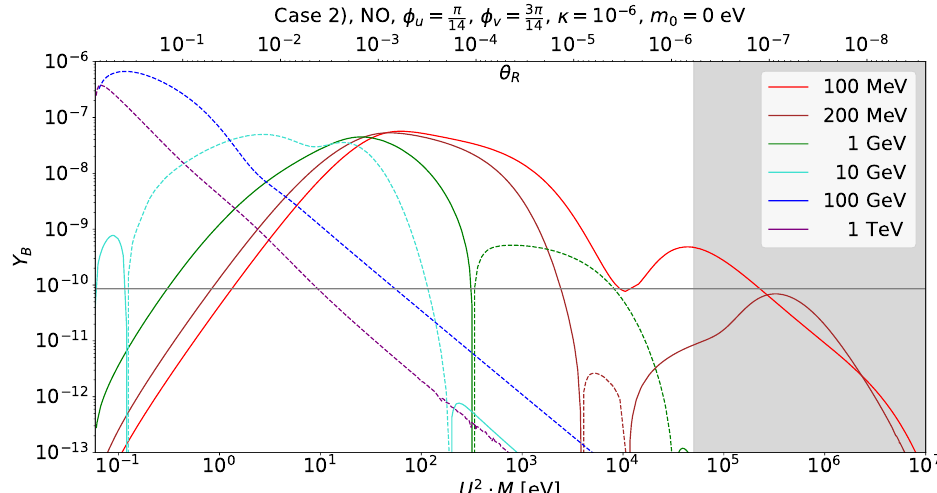
Figure 35 . Case 2) Y B as function of U 2 · M for different values of the heavy neutrino mass M . The splitting κ is fixed to 10 − 6 . Light neutrino masses follow strong NO. The group theory parameters n , u and v are chosen as n = 14 , u = 1 and v = 3 corresponding to φ u = π negative (dashed lines) as well as positive (continuous lines) values of the BAU are represented. The grey line indicates the observed value of the BAU, Y the region in which a criterion similar to the one in eq. (3.69) is not